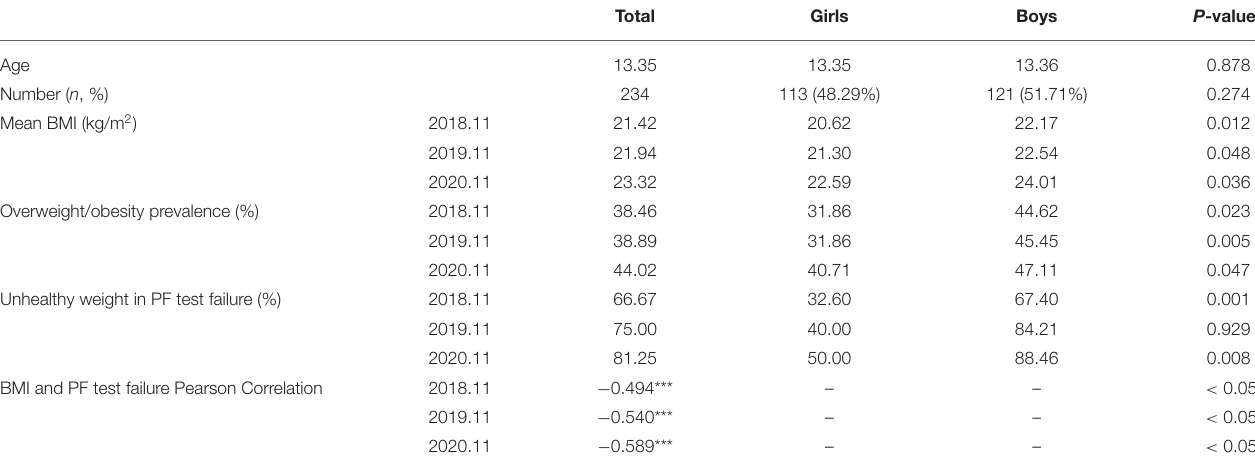
TABLE 2 | Descriptive and correlational analyses of the study population.